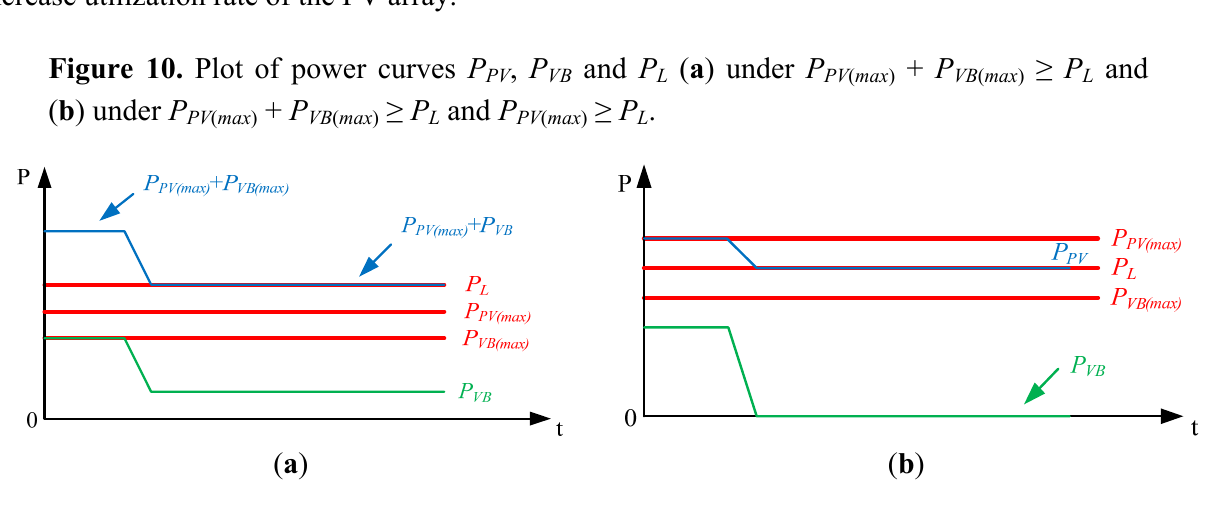
Figure 10. Plot of power curves P